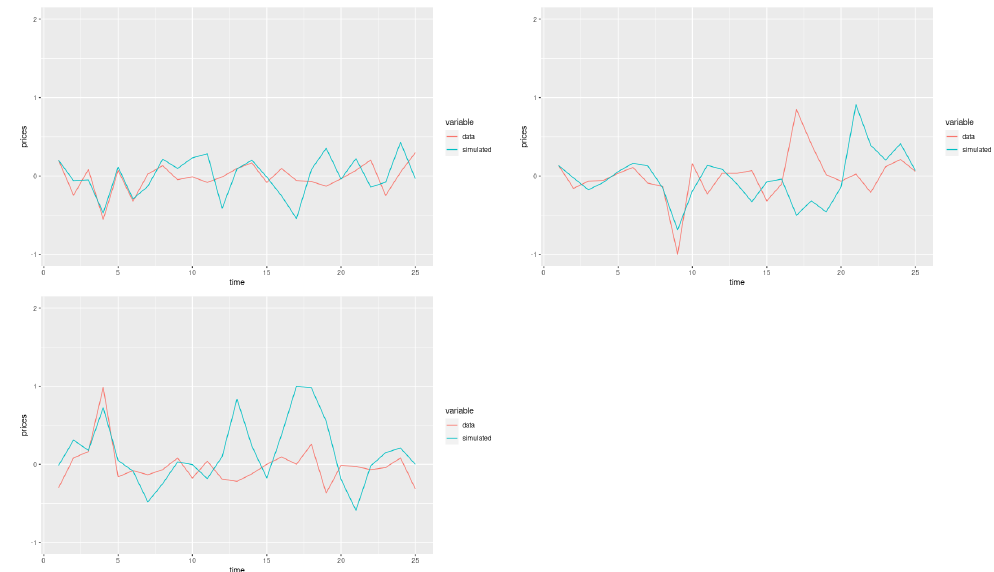
Figure 10. Price trajectories generated by the model (54) vs. the copper price data. Temporal ranges: (v) on the left, (vi) on the right and (vii)